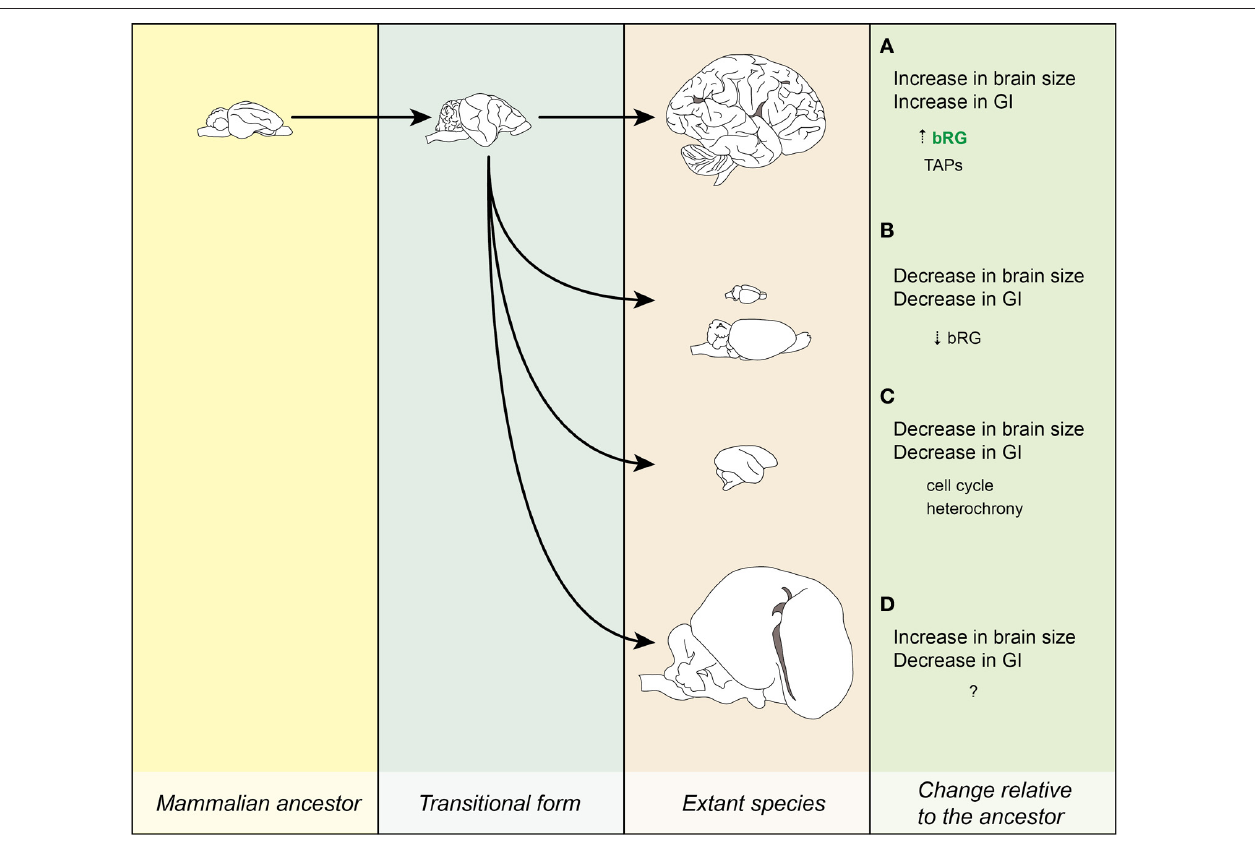
FIGURE 5 | Evolution of the neocortex. Lineages leading to extant species. (A) Increase in brain size led to the increase in GI. The processes leading to this transition might have been that the bRG were present at a certain significant number (marked by green letters) and that they have evolved the ability to produce TAPs. Example: human. (B) Dwarfing I. Decrease in brain and body size relative to the ancestor is accompanied by a reduction in GI. The reduction in the number of bRG might have underlain this